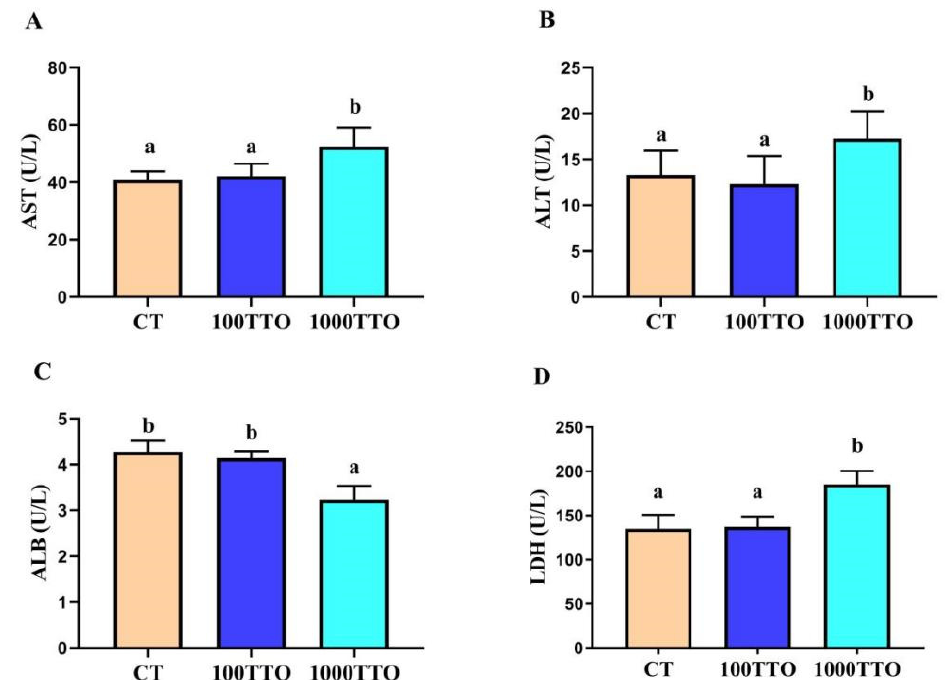
Figure 2. Effect of dietary TTO levels on hepatopancreatic function indicators of M. rosenbergii . ( A ) AST activity; ( B ) ALT activity ( C ) ALB activity; ( D ) LDH activity. The significant difference between the three TTO levels is characterized by different lowercase letters (a, b) ( p <